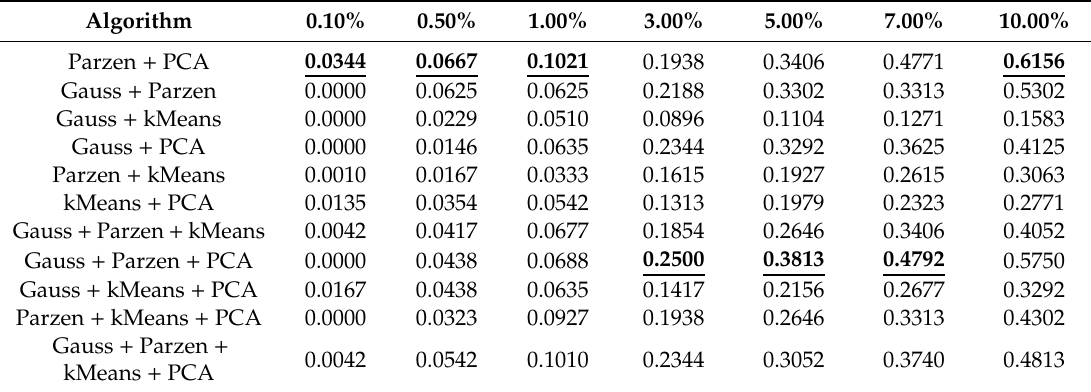
Table A6. True detection rate of each anomaly detection algorithm based on the daily activity summary dataset (Salesman). Best performance is shown in bold and